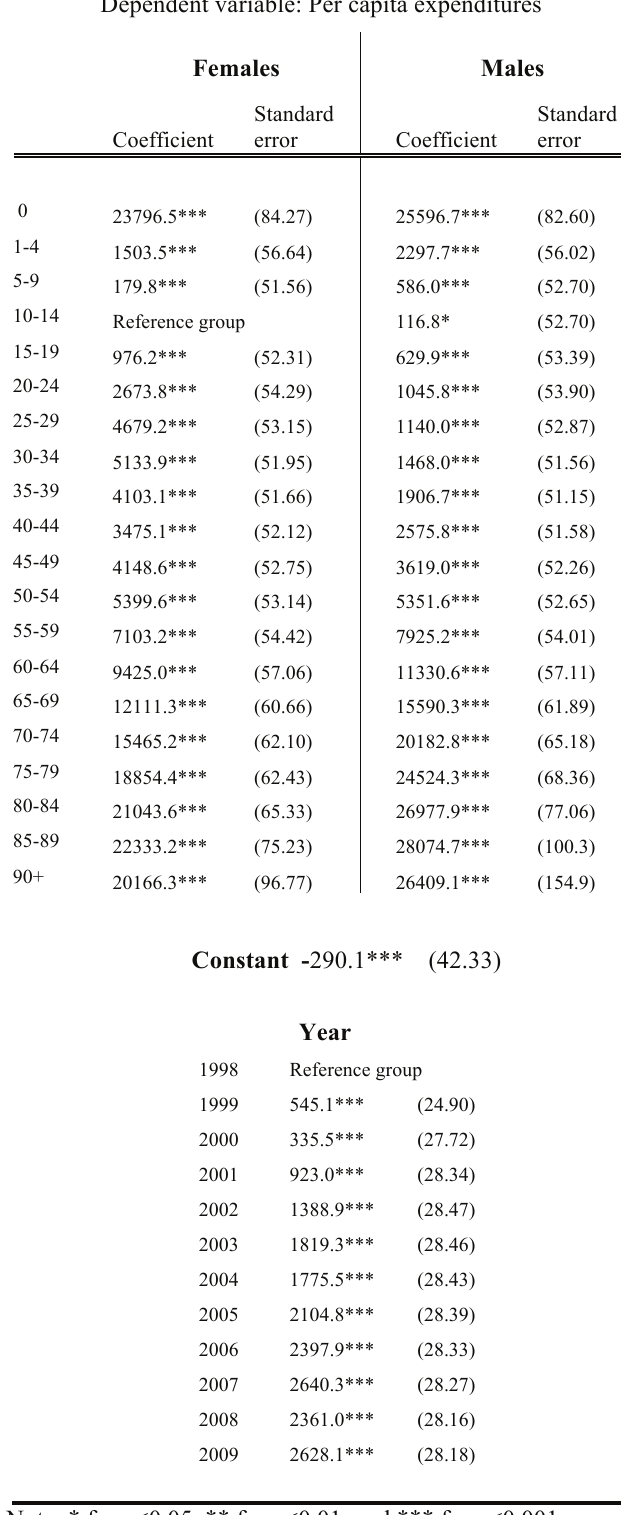
Table 3b: Results from weighted regression analysis of hospital expenditures assuming serial correlation in error terms – without controlling for mortality Dependent variable: Per capita expenditures Females